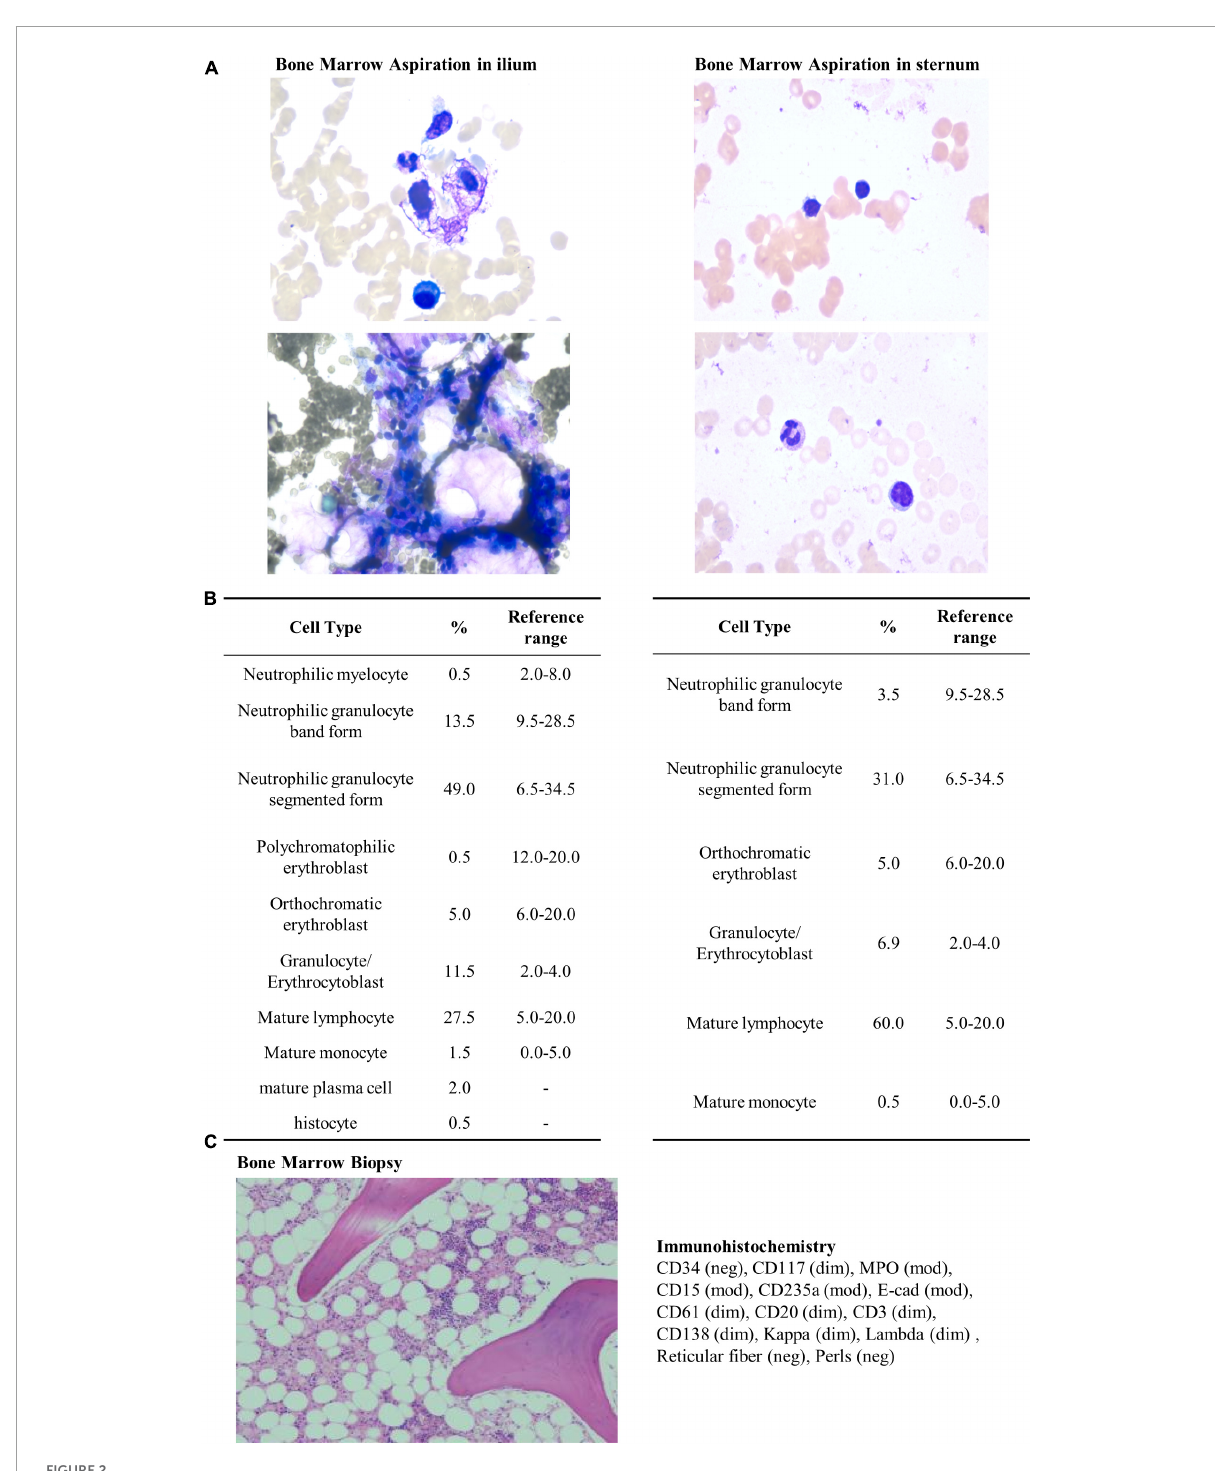
FIGURE2 Bone marrow aspiration, biopsy, and immunohistochemistry. Bone marrow aspiration was performed using Wright’s staining technique. Bone marrow biopsy and immunohistochemistry were performed using staining techniques involving hematoxylin, Giemsa, acid fuchsin, reticular fiber, and Prussian blue stains. (A) Bone marrow aspiration in ilium performed on May 20, 2022. The results reveal low proliferation of nucleated cells without abnormality in morphology. (B) Bone marrow aspiration in sternum performed on May 24, 2022. The results reveal low proliferation of nucleated cells without abnormality in morphology. (C) Bone marrow biopsy and immunohistochemistry performed on May 20, 2022. Hematopoietic elements are substantially reduced (30%), and bone marrow space is replaced with adipose tissue (70%). Granulocyte and erythrocyte development are